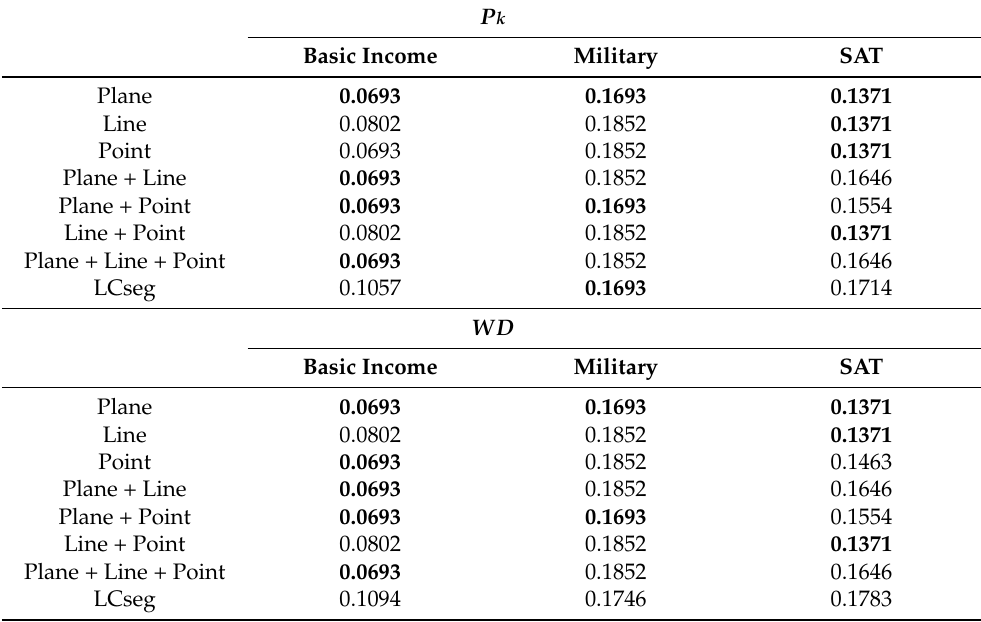
Table 2. P k and WD values of each similarity cohesion calculation method without applying debate consistency metrics of CSseg.